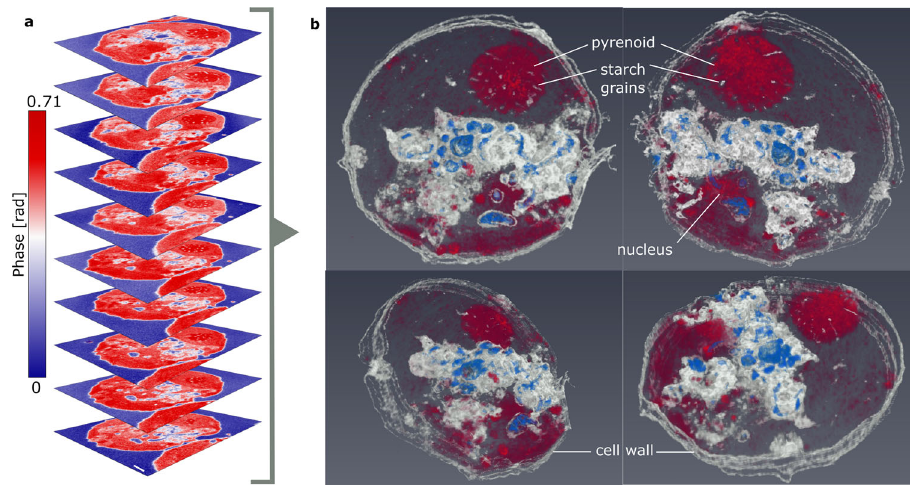
Fig. 5 sSNOM tomography of a C. reinhardtii section. Ten sSNOM images of consecutive C. reinhardtii cross sections, recorded at 1656 cm − 1 ( a ) used for the construction of a tomogram ( b ), shown in four orientations: top right — view from the top, top left — view from the bottom, bottom left — top view tilted, bottom right - bottom view tilted (Supplementary Movie 1). Scale bar equals 1 µ